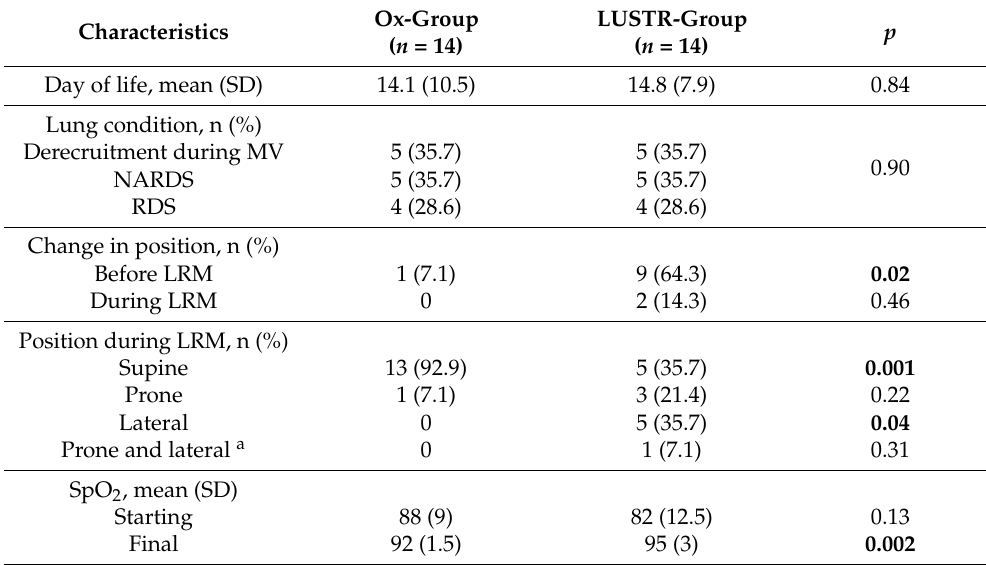
Table 2. Characteristics of the LUSTR-group and Ox-group.